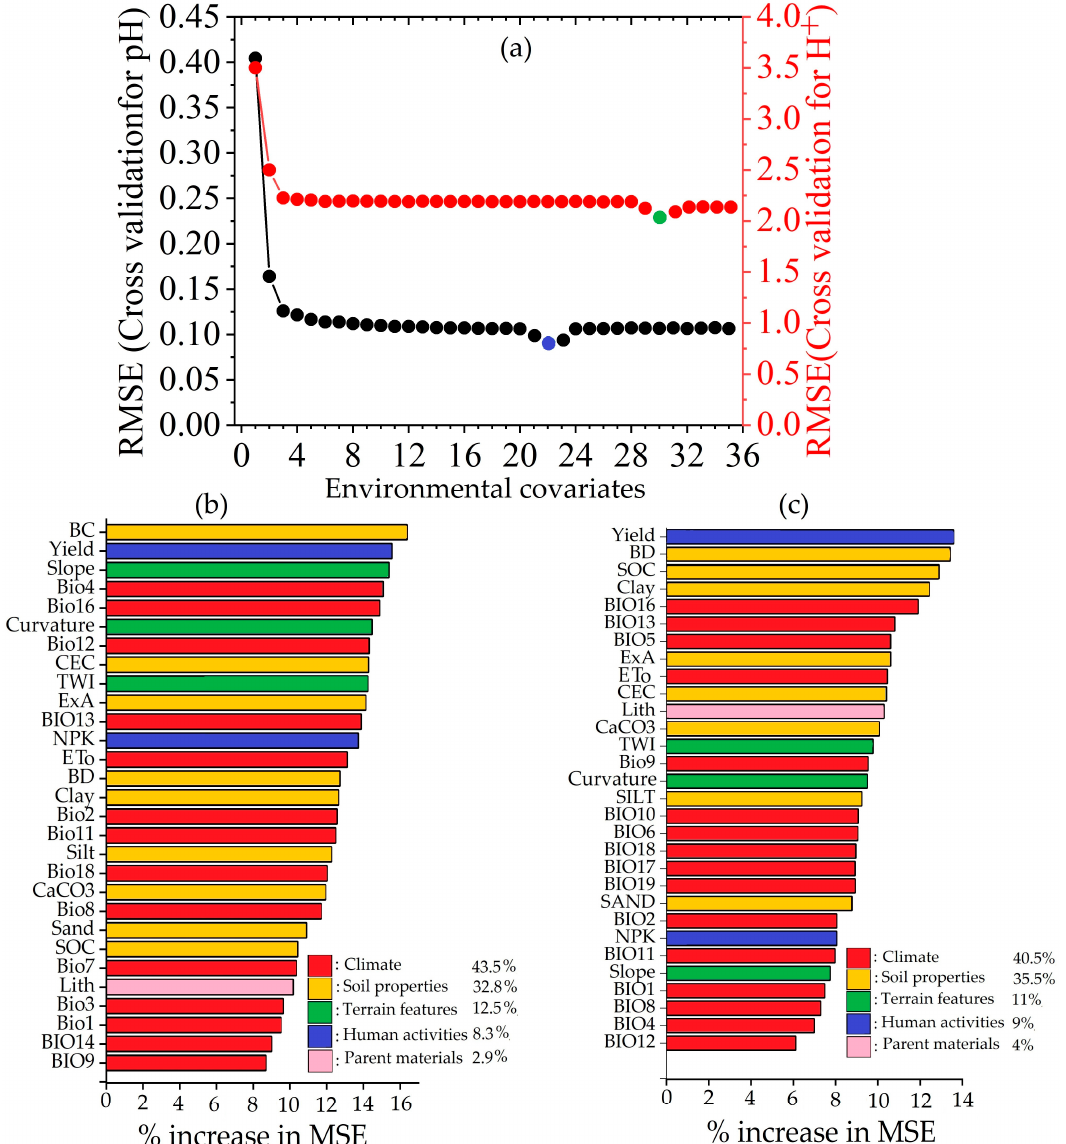
Figure 3. Covariates selection and covariates importance: Figure ( a ) represents root mean square error (RMSE) for different numbers of covariates included in the ensemble machine learning models for soil pH and soil acidification rate as determined by recursive feature elimination. A green coloured circle and blue coloured circle represent the optimal number of covariates for soil acidification rate (32 covariates) and soil pH (22 covariates), respectively. Figures ( b , c ) represent the relative importance of selected environmental covariates (in figure ( a )) for soil acidification rate and soil pH predictions, respectively. %IncMSE stands for the increase in mean standard errors. (Abbreviations